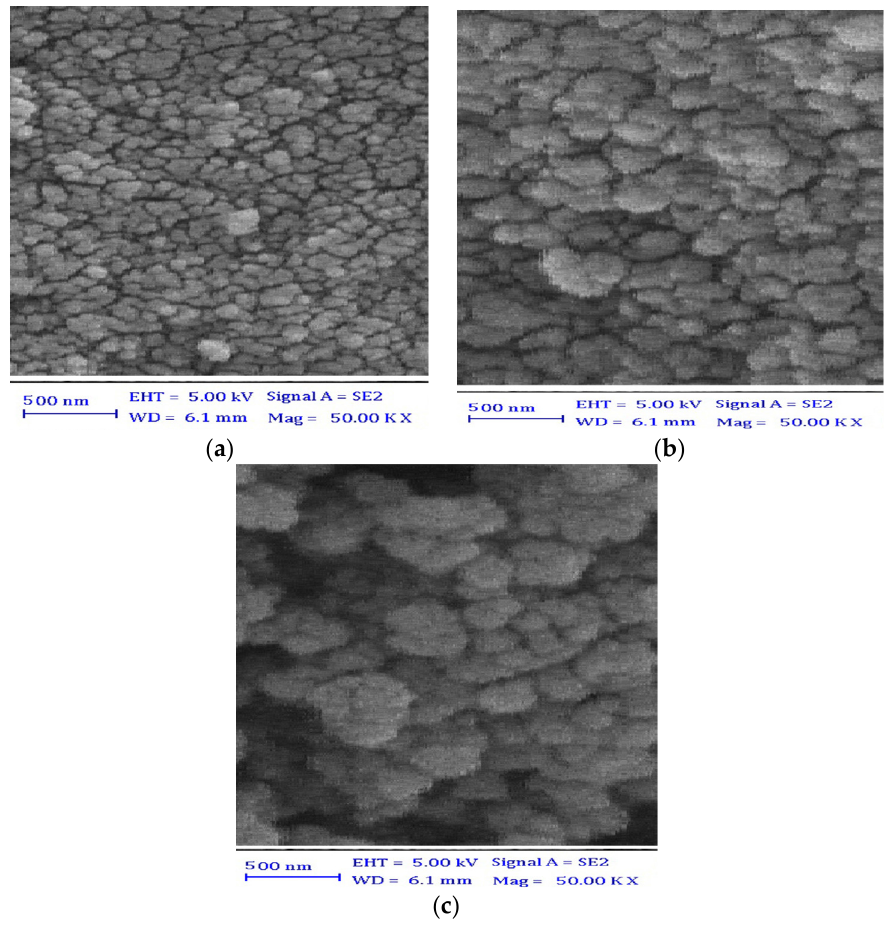
Figure 2. SEM images of Fe 3 O 4 nanoparticles ( a ), Fe 3 O 4 /SiO 2 nanocomposite ( b ), and PPy/Fe 3 O 4 /SiO 2 nanocomposite ( c ).